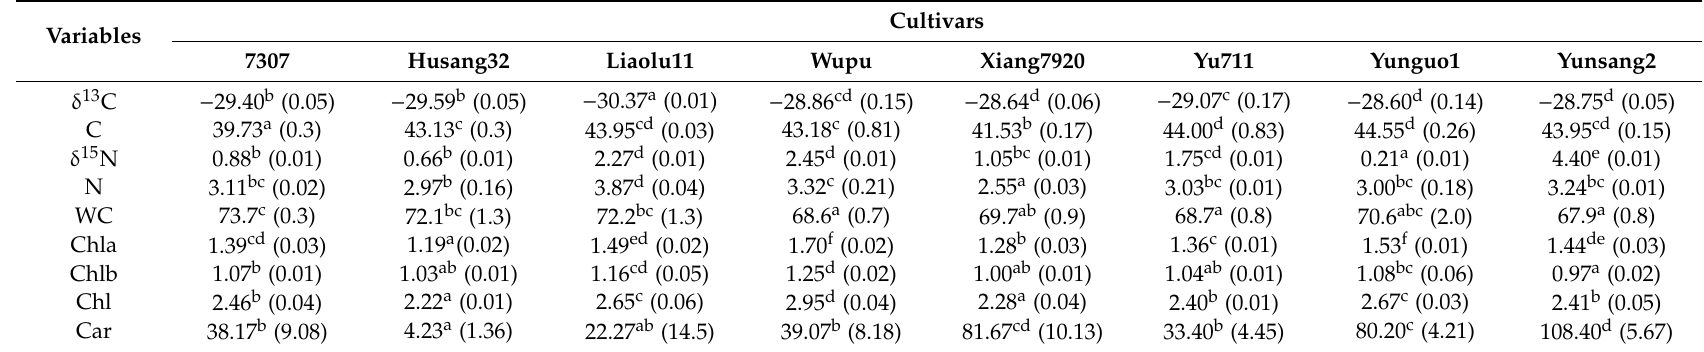
Table 2. Leaf physiological traits: foliar water content (WC, %), chlorophyll a content (chla, mg g − 1 Fw), chlorophyll b content (chlb, mg g − 1 Fw),